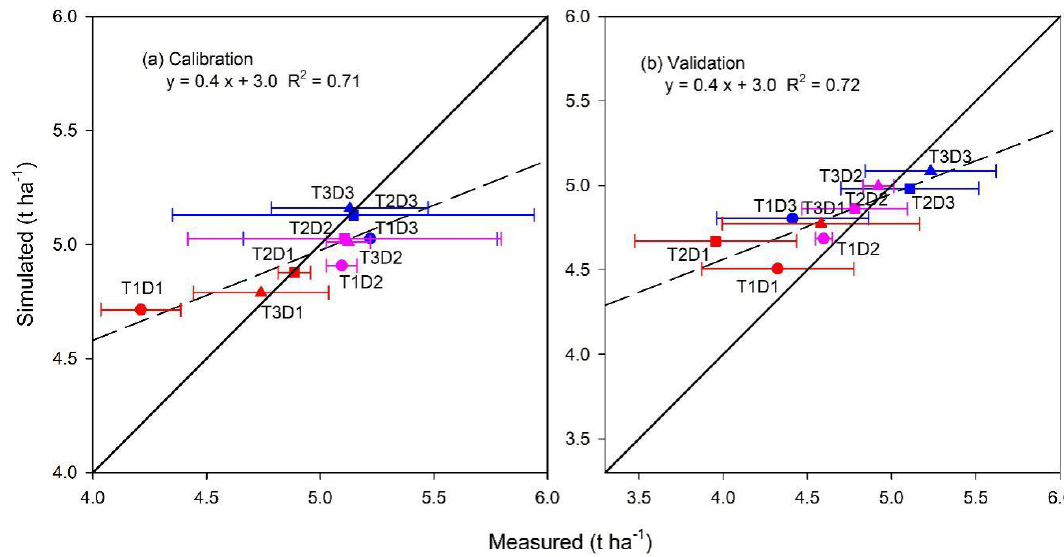
Figure 4. Simulated and measured pod yield of peanut under three sowing dates * three planting densities during calibration (( a ), 2017) and validation (( b ), 2018) stage. Values are means of three replicates. Broken line, regression line; solid line, 1:1 line. represents T1, (cid:3) represents T2, (cid:52) represents (cid:35) T3; red represents D1, pink represents D2, blue represents